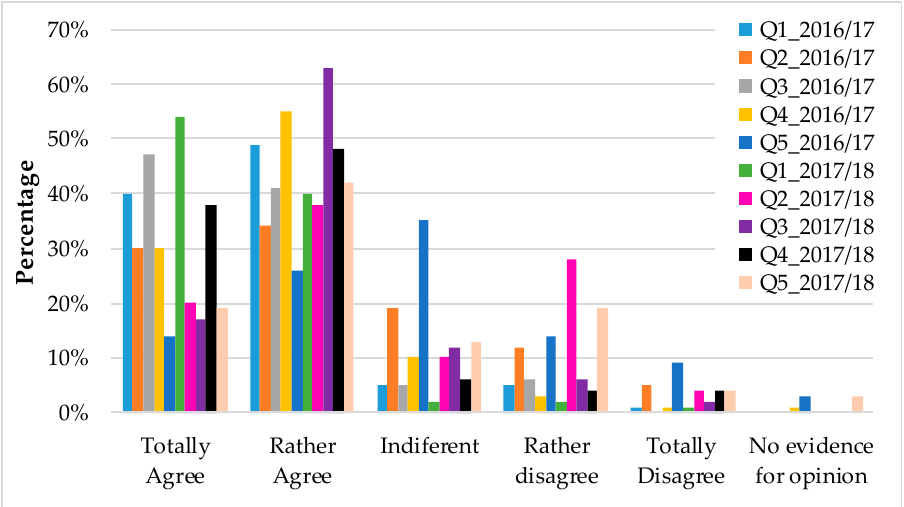
Figure 5. Survey to analyze the development of the project in the topic: hydraulic machines for the 2017 and 2018 years.